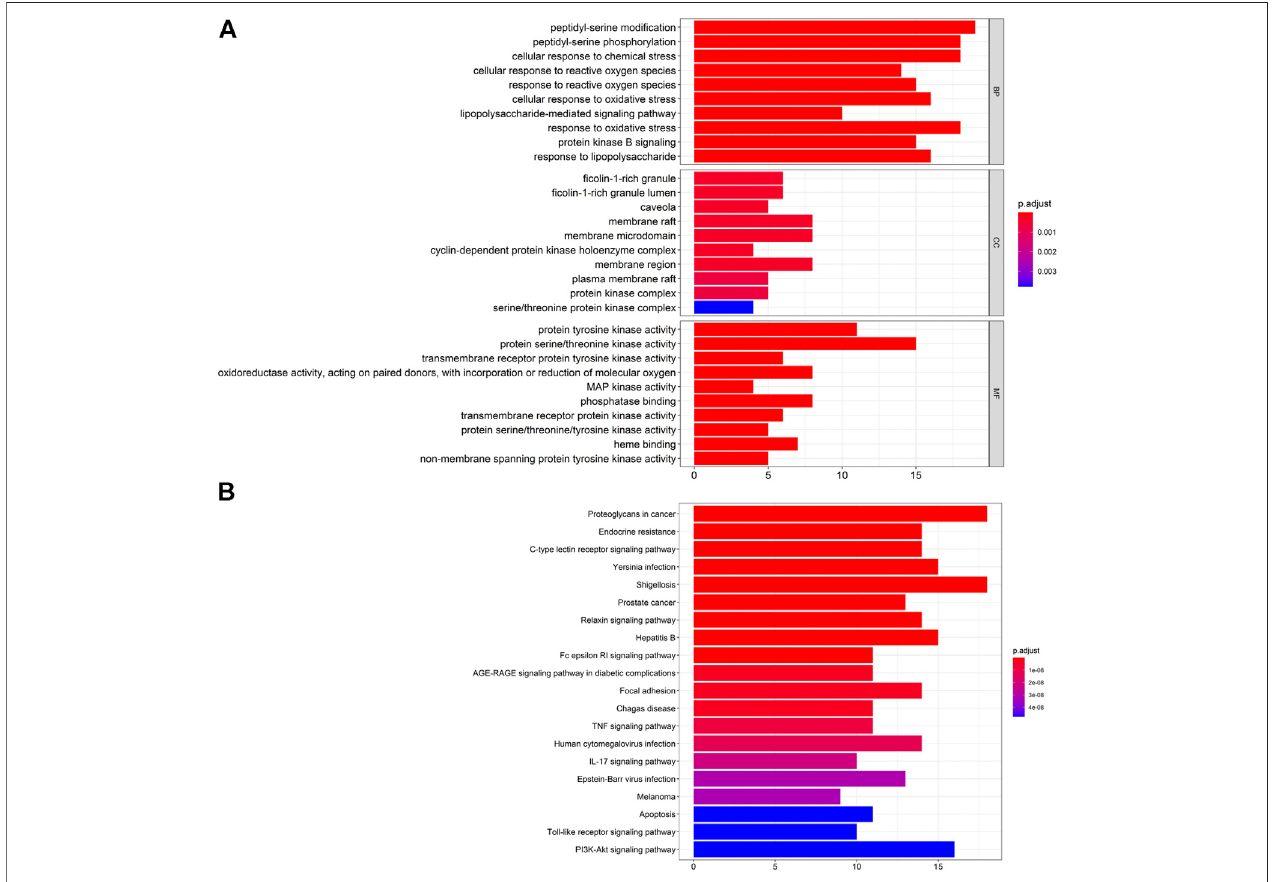
FIGURE 4 | (A) Analyses of 65 targets associated with gouty arthritis using the GO database. The x-axis represents signi fi cant enrichment of these term counts. The y-axis represents the category of "biological process ” , “ cellular component ” and “ molecular function ” in the GO of target genes ( p < 0.05). (B) Pathway-enrichment analyses using the KEGG database. The x-axis represents the count of targets in each pathway; the y-axis represents the primary pathway ( p <